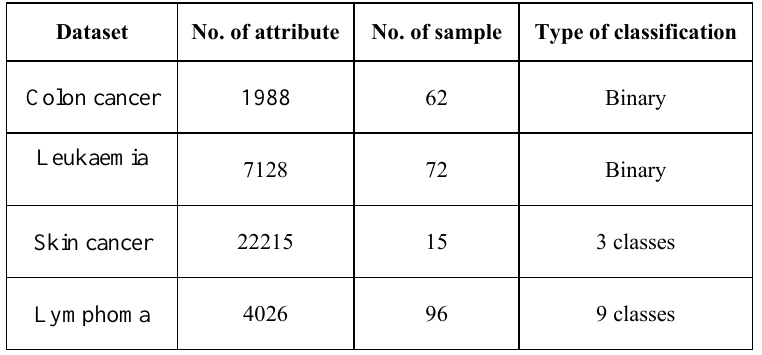
Table 1. Summary of the downloaded